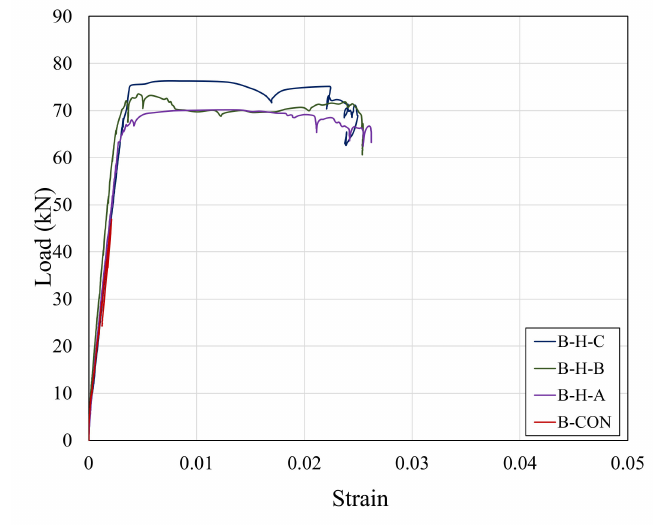
Figure 16. Load-strain curves of control and cotton FRRP strengthened beams. Table 8. Strain of steel